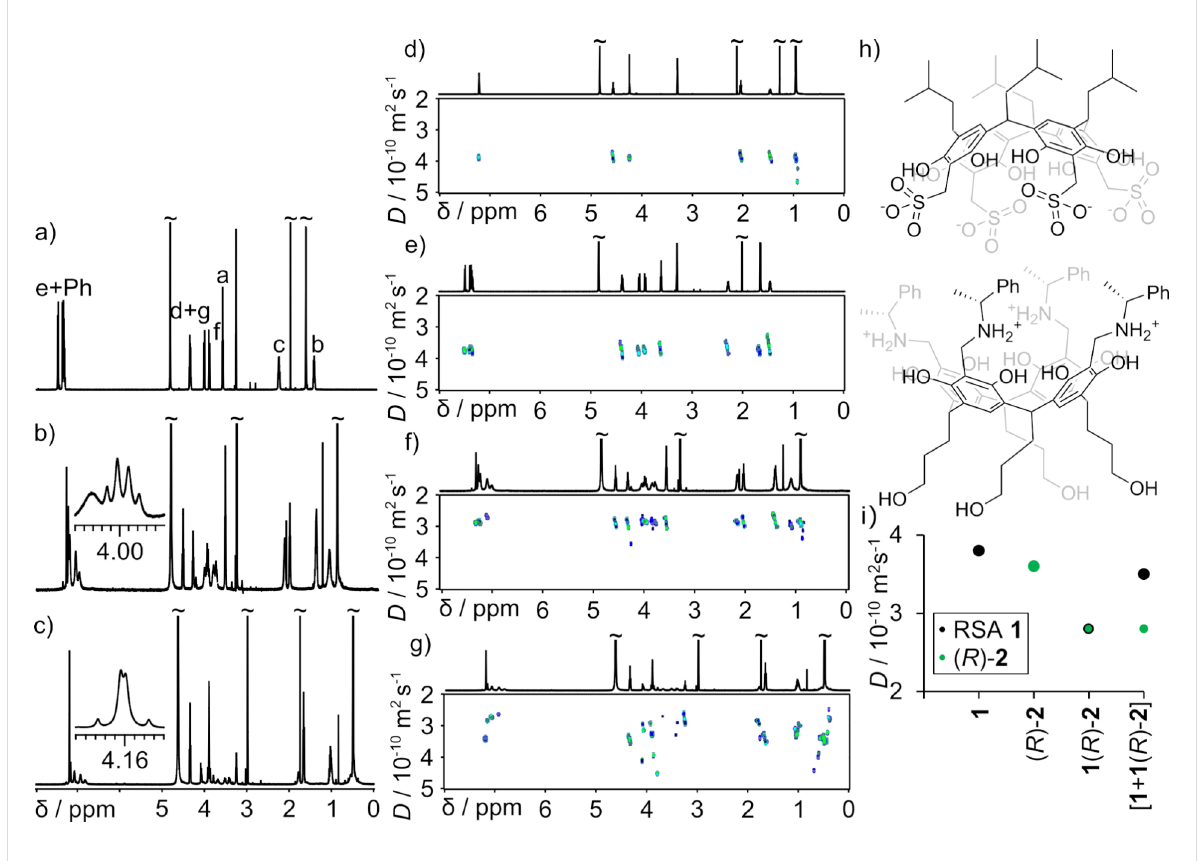
Figure 6: 1 H NMR spectra of ( R )- 2 (a); [ 1 (( R )- 2 ] (b); [ 1 + 1 (( R )- 2 ] (c) (insets show the shape of signals f, methanol- d 4 , 298 K, 600 MHz); DOSY spec- tra of 1 (d); ( R )- 2 (e); [ 1 (( R )- 2 )] (f); [ 1 + 1 (( R )- 2 )] (g). Proposed capsular structure of 1 (( R )- 2 ) (h); Cumulative plot of diffusion coefficients (i) (methanol- d 4 , 298 K, 600